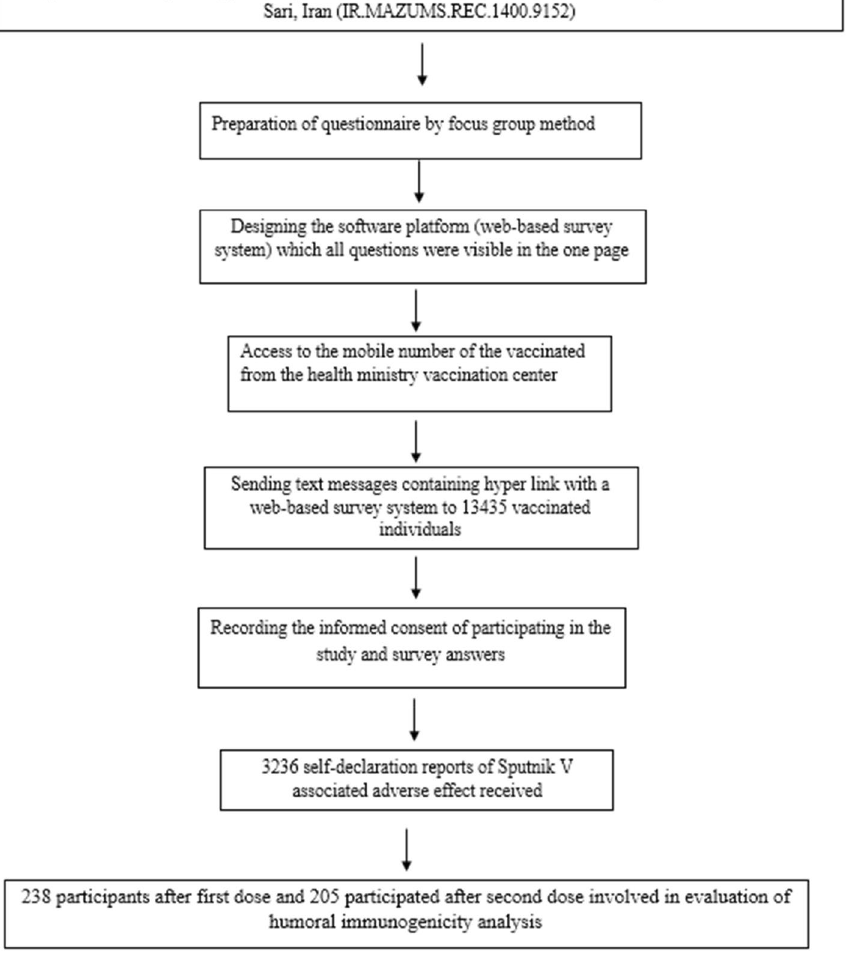
Figure 1. Flow chart of study